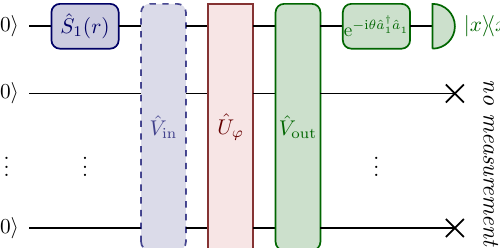
Figure 2. Schematic diagram of the setup described in Section 2.1. The squeezed vacuum state in Equation (2) is injected in the first channel of a network composed of a first auxiliary stage ˆ V in , a network ˆ U ϕ which depends on a generally distributed parameter ϕ we want to estimate, and a second auxiliary stage ˆ V out , before being detected through homodyne measurements in the first output port. The role of the two auxiliary stages ˆ V in and ˆ V out is to respectively distribute the photons of the probe through multiple channels, and then to refocus them into the only observed channel. We will show that only one auxiliary network needs to be optimized to reach the Heisenberg scaling, while, for networks with a large number of channels, the effect of the non-optimized network is typically irrelevant on the overall precision of the estimation [42]. Reprinted with permission from ref. [42], © 2021 The